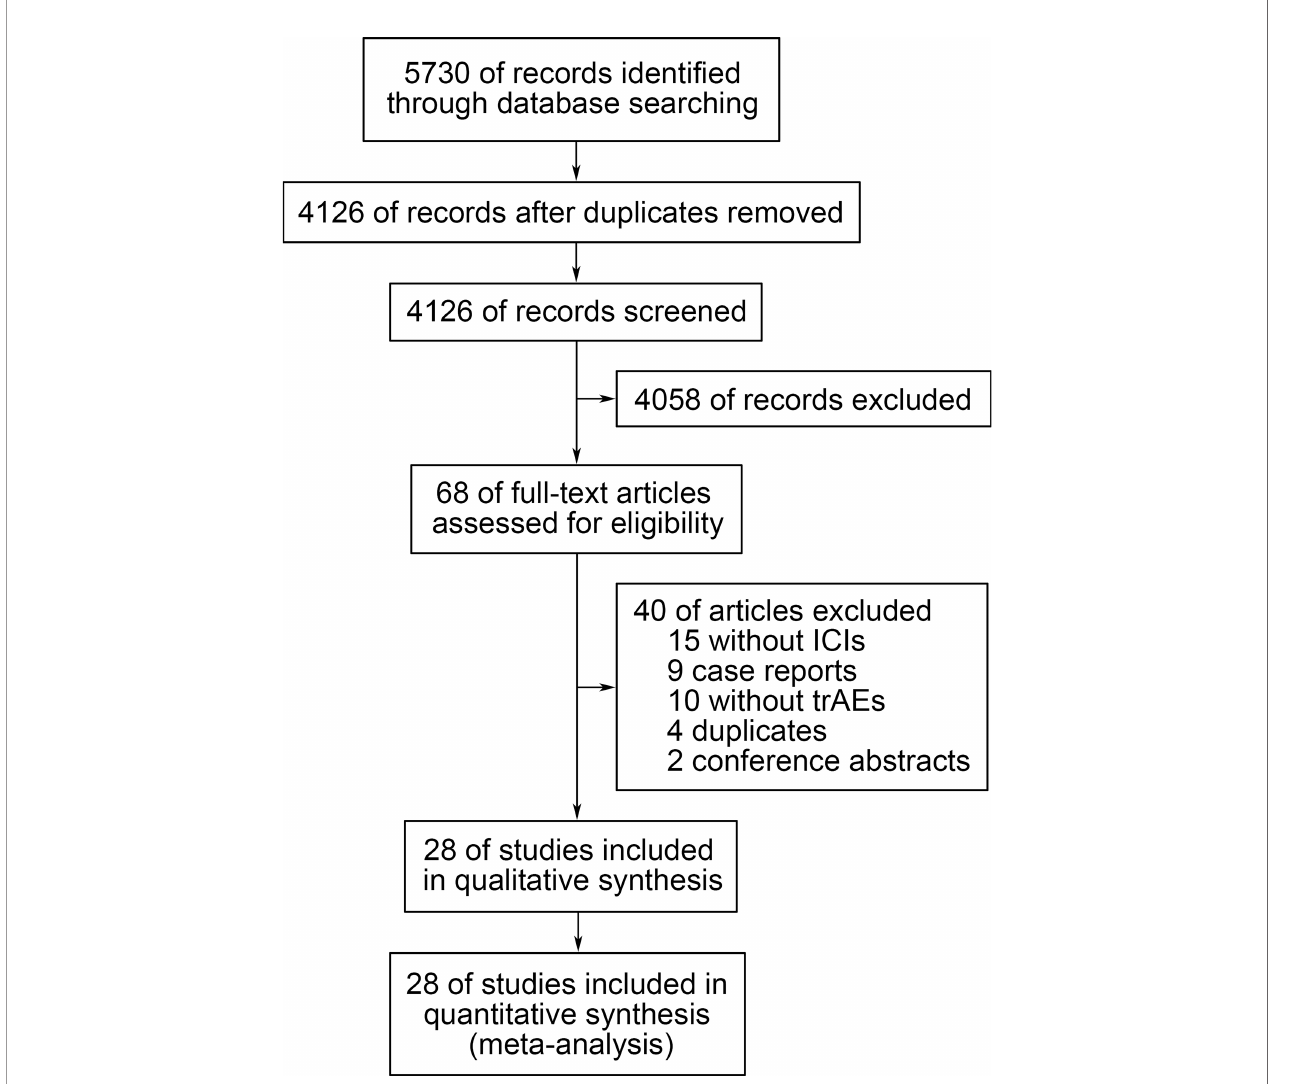
FIGURE 1 | Flow diagram of the study selection process. trAEs, treatment-related adverse events; ICIs, immune checkpoint